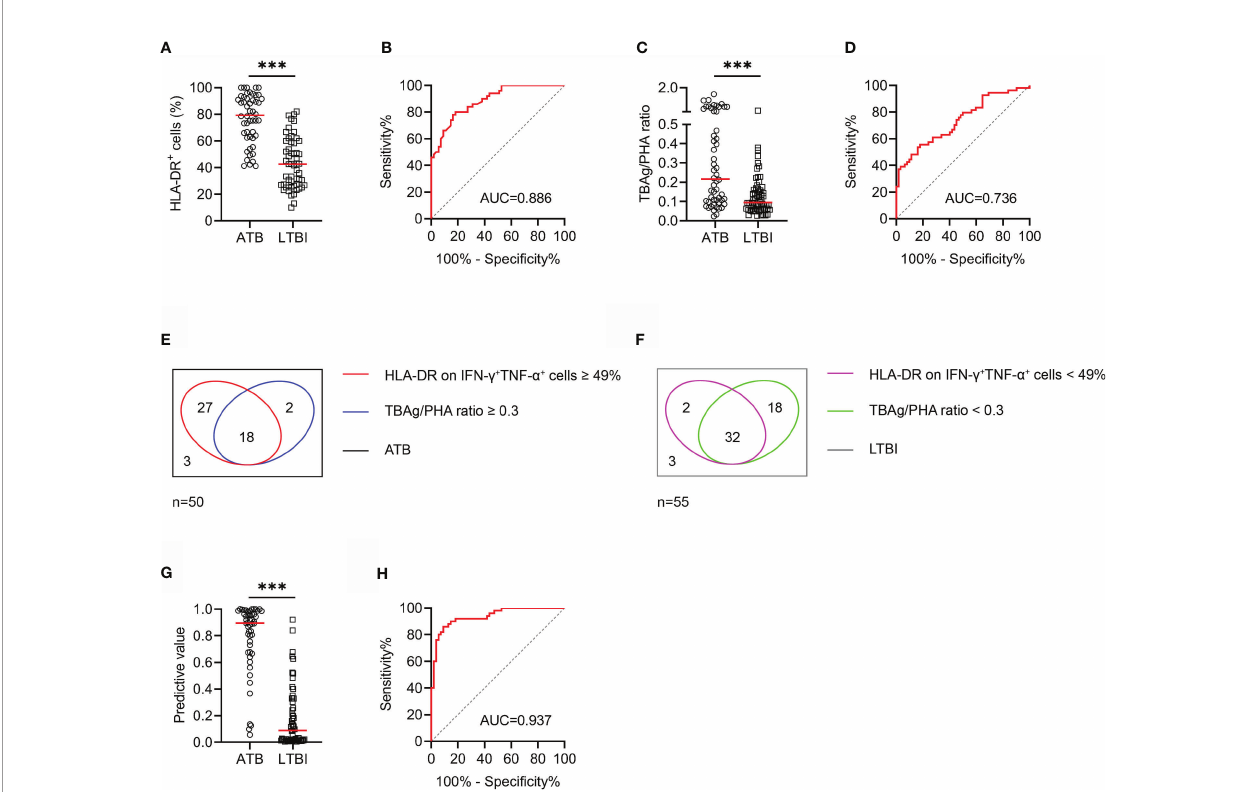
FIGURE 2 | The performance of various indicators in distinguishing ATB patients from LTBI individuals in Qiaokou cohort. (A) Scatter dot plots showing the results of the expression of HLA-DR on IFN- g + TNF- a + cells in ATB patients and LTBI individuals. Horizontal lines indicate the medians. *** P < 0.001 (Mann-Whitney U test). (B) ROC curve analysis showing the performance of HLA-DR on IFN- g + TNF- a + cells in discriminating ATB patients from LTBI individuals. (C) Scatter dot plots showing the results of TBAg/PHA ratio in ATB patients and LTBI individuals. Horizontal lines indicate the medians. *** P < 0.001 (Mann-Whitney U test). (D) ROC curve analysis showing the performance of TBAg/PHA ratio in discriminating ATB patients from LTBI individuals. (E) Venn diagrams showing the overlap of HLA-DR on IFN- g + TNF- a + cells and TBAg/PHA ratio in ATB patients. (F) Venn diagrams showing the overlap of HLA-DR on IFN- g + TNF- a + cells and TBAg/PHA ratio in LTBI individuals. (G) Scatter plots showing the predictive value of diagnostic model in ATB patients and LTBI individuals. Horizontal lines indicate the medians. *** P < 0.001 (Mann-Whitney U test). (H) ROC curve analysis showing the performance of diagnostic model based on the combination of HLA-DR on MTB-speci fi c cells and TBAg/PHA ratio in discriminating ATB patients from LTBI individuals. MTB, Mycobacterium tuberculosis ; ATB, active tuberculosis; LTBI, latent tuberculosis infection; TBAg, tuberculosis antigens; PHA, phytohemagglutinin; AUC, area under the